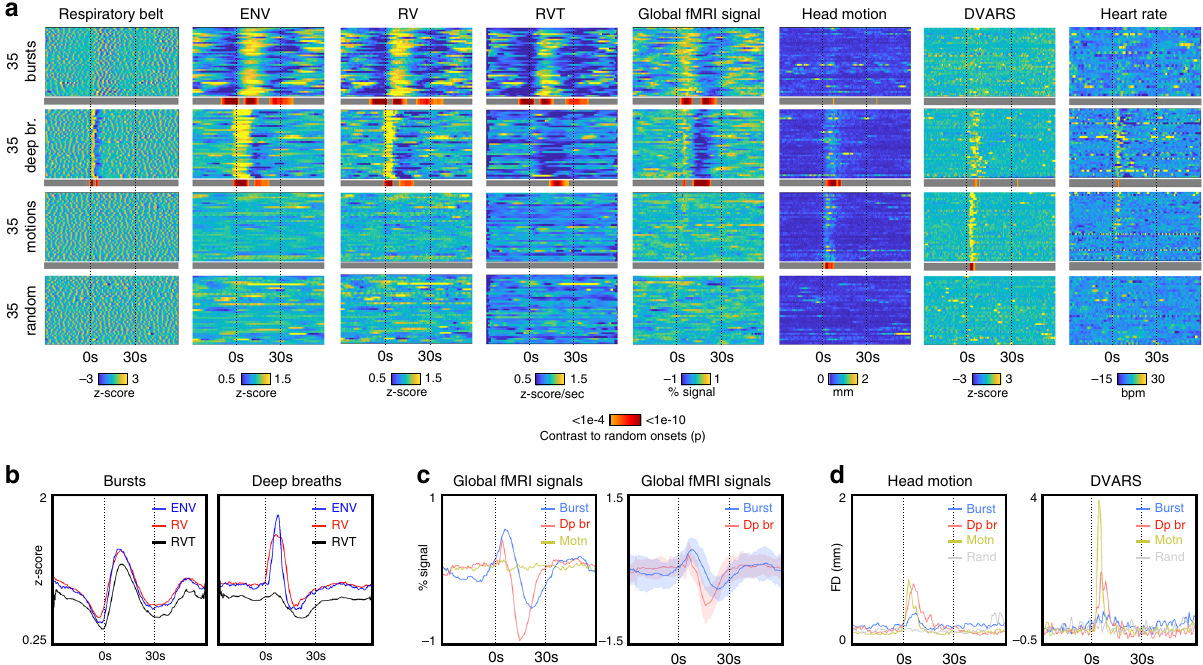
Fig. 3 Properties of deep breaths and bursts. a Heat maps at the top illustrate 90-s segments surrounding visually identi fi ed events. In different subjects, 35 examples each of bursts, deep breaths, and isolated non-respiratory motions were identi fi ed from respiratory belt traces and motion traces. In the motion-exhibiting subjects, a random set of timepoints was also selected. Illustrated are respiratory belt traces, three respiratory measures (ENV, RV, and RVT), the global (gray matter average) fMRI signal, head motion (framewise displacement, following fi ltering, and 4-TR calculation as in ref. 16 ), and DVARS ( z -scored). A gray/red heatmap represents statistically signi fi cant differences from the random events (two-sample t -test, two-tailed) beyond p < 0.001, illustrated on a logarithmic scale capped at p < 1e − 10. The basis of bursts and deep breaths are apparent in the respiratory belt images. b Mean signals of ENV, RV, and RVT congruently mark bursts, but deep breaths display differences across the respiratory measures, with RVT having little positive de fl ection. c Mean global fMRI signals differ across patterns: deep breaths have brief signal increases and marked signal decreases with nadir near 15 s, and 30 s to resolution, on average. Bursts have more marked positive de fl ections, and slower timecourses on average, resolving near 40 s on average. Motion produces no global fMRI signal changes. Shade plots re fl ect mean and std. d Deep breaths display considerable motion and DVARS changes time-locked to event onsets; bursts have smaller time-locked modulations that do not achieve signi fi cance. Source data are provided as a source data fi